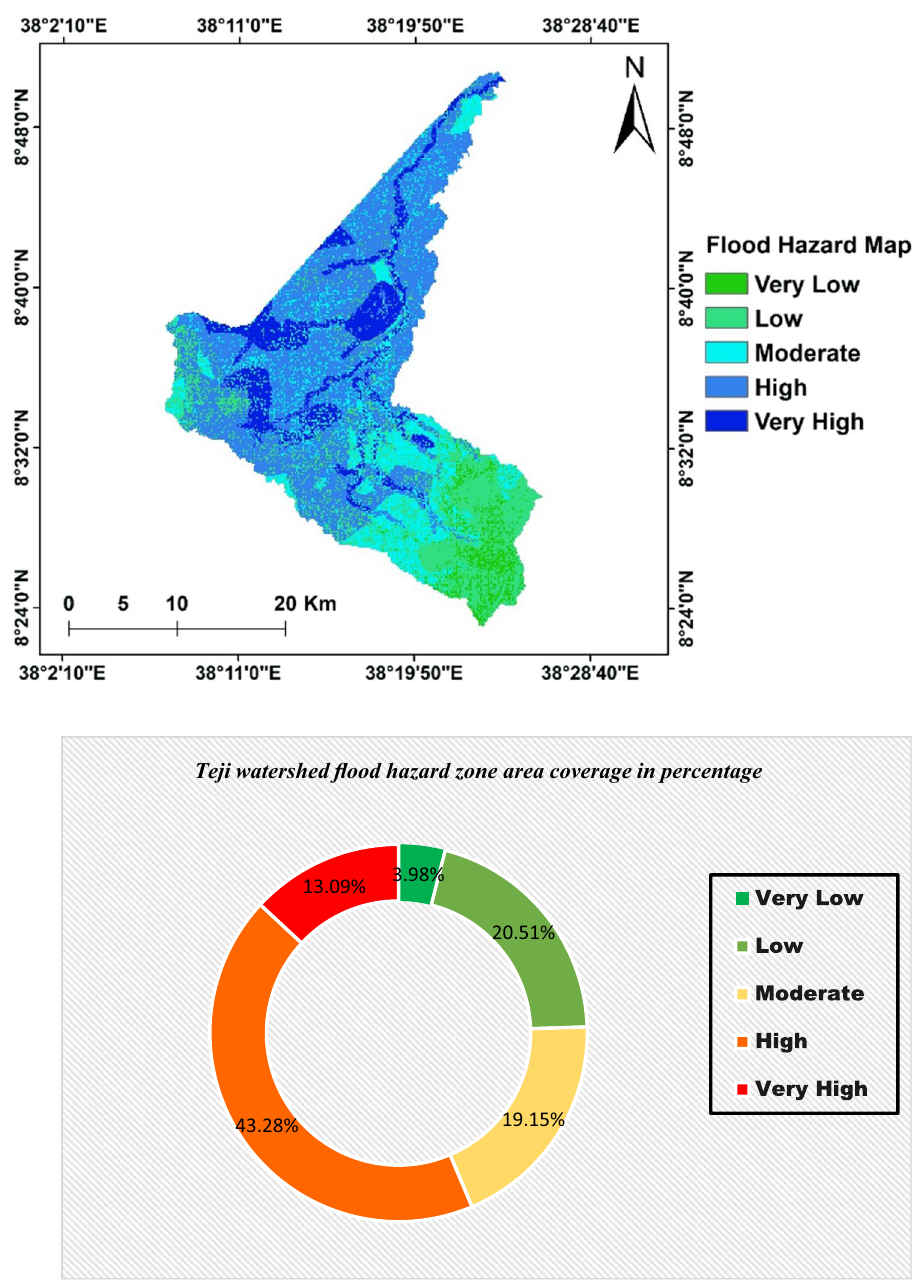
Figure 10 Flood Hazard Map of